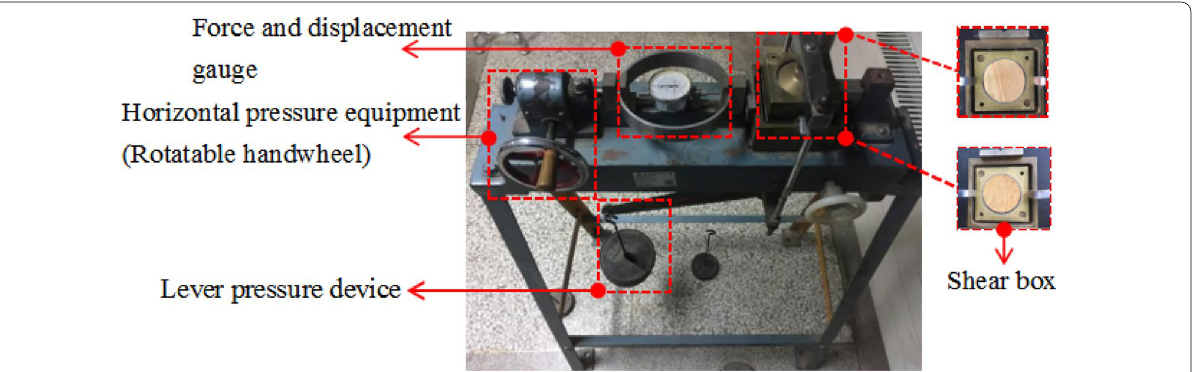
Fig. 14 Test setup